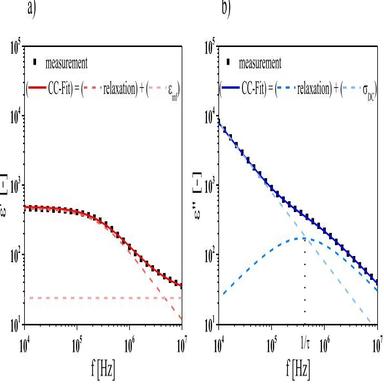
Simultaneous fit for ε ′ (a) and ε′′ (b) according to the Cole-Cole equation with Ohmic conductivity σDC and infinite permittivity εinf terms.